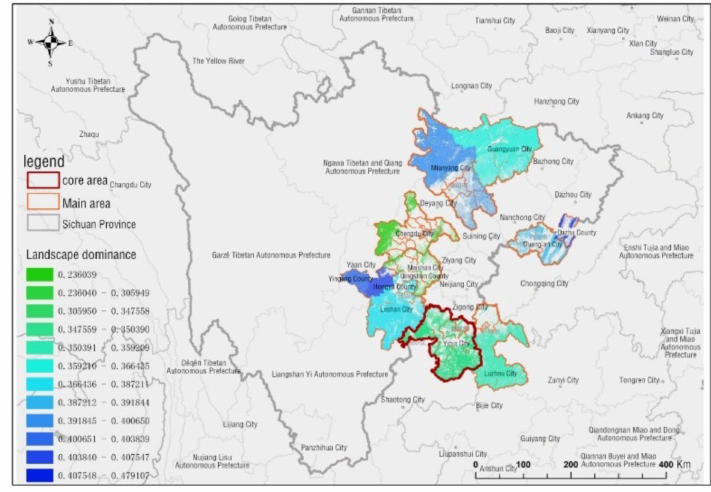
Figure 17. Landscape pattern index (landscape dominance) of research areas in Sichuan Province.